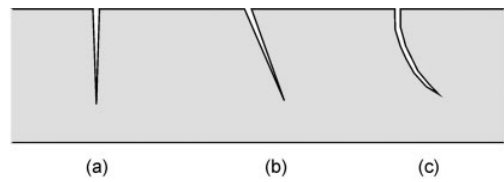
Fig. 6. Scheme of the characteristic geometry of cracks